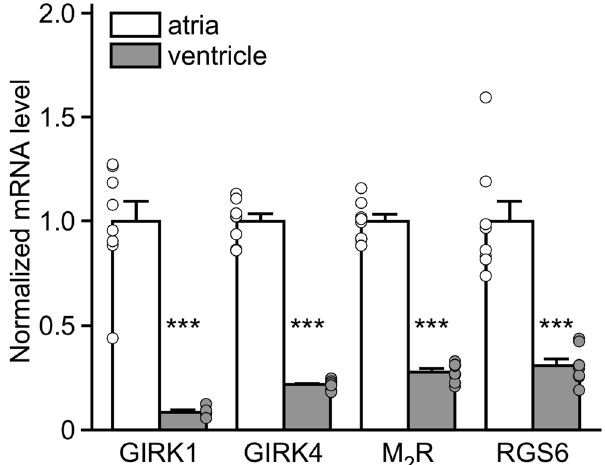
Figure 1. Expression of I KACh -dependent signaling elements in mouse atria and ventricle. mRNA levels of GIRK1 ( t 14 = 9.4, *** P < 0.001), GIRK4 ( t 14 = 21.2, *** P < 0.001), M 2 R ( t 13 = 18.6, *** P < 0.001), and RGS6 ( t 14 = 6.7, *** P < 0.001), and in atria and ventricle from adult C57BL/6J mice, compared using an unpaired Student’s t-test. mRNA levels of each target were normalized to the level of GAPDH mRNA measured in each sample. Ventricular mRNA levels for each target was normalized to the level present in atrial samples (n = 7–8 samples per tissue, per